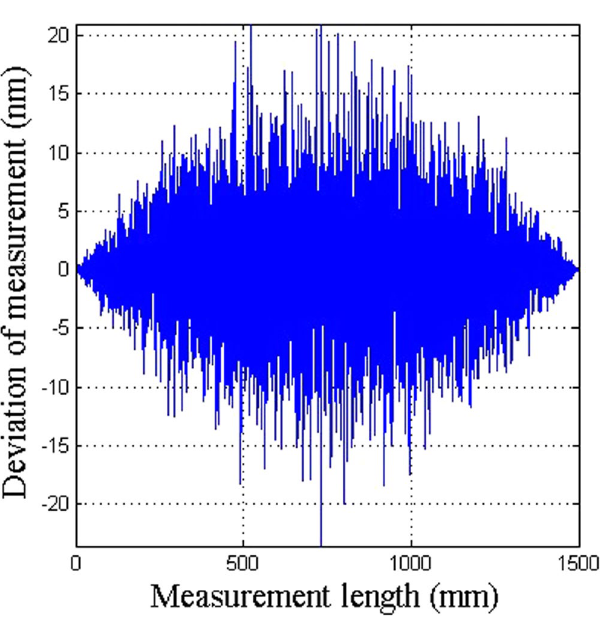
Figure 6. The accuracy of the two-color heterodyne laser interferometer with correction of the uncertainty in the optical distances without considering the uncertainty in the humidity.